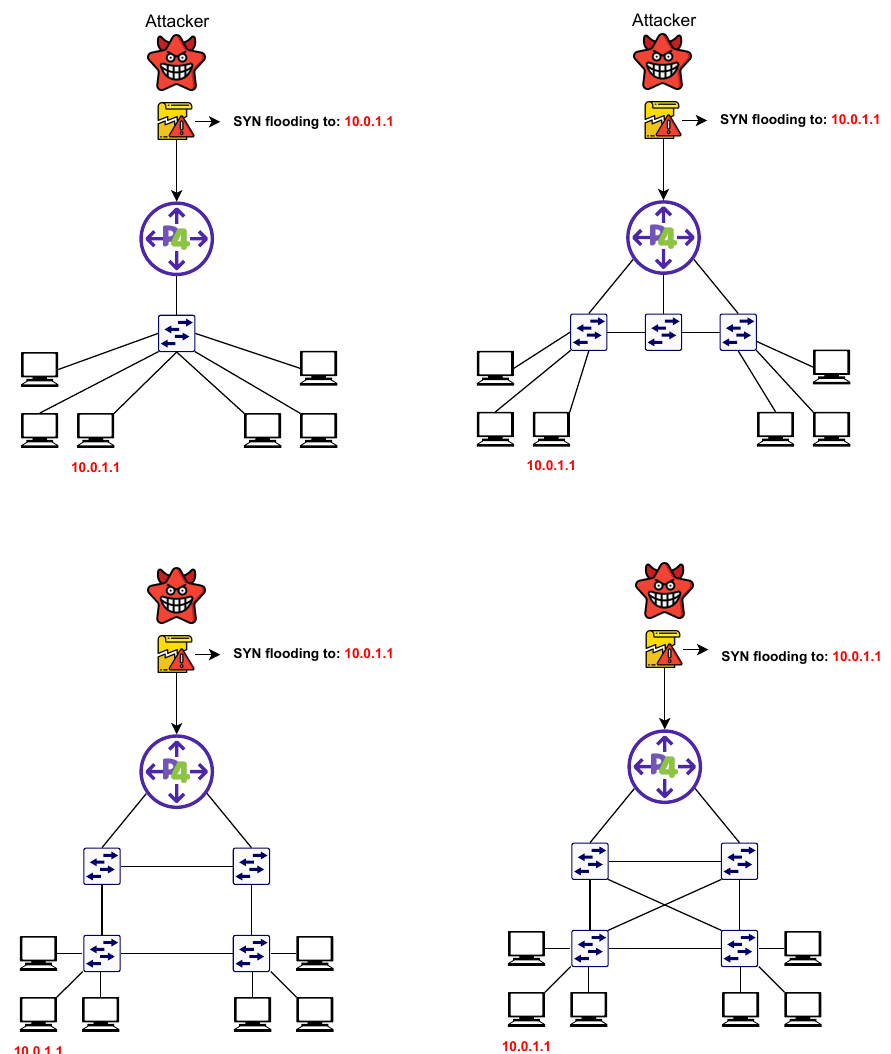
Figure 6. Network topology used for the testing phase. From the top-left corner, clockwise: single switch topology; linear topology; ring topology; fully connected